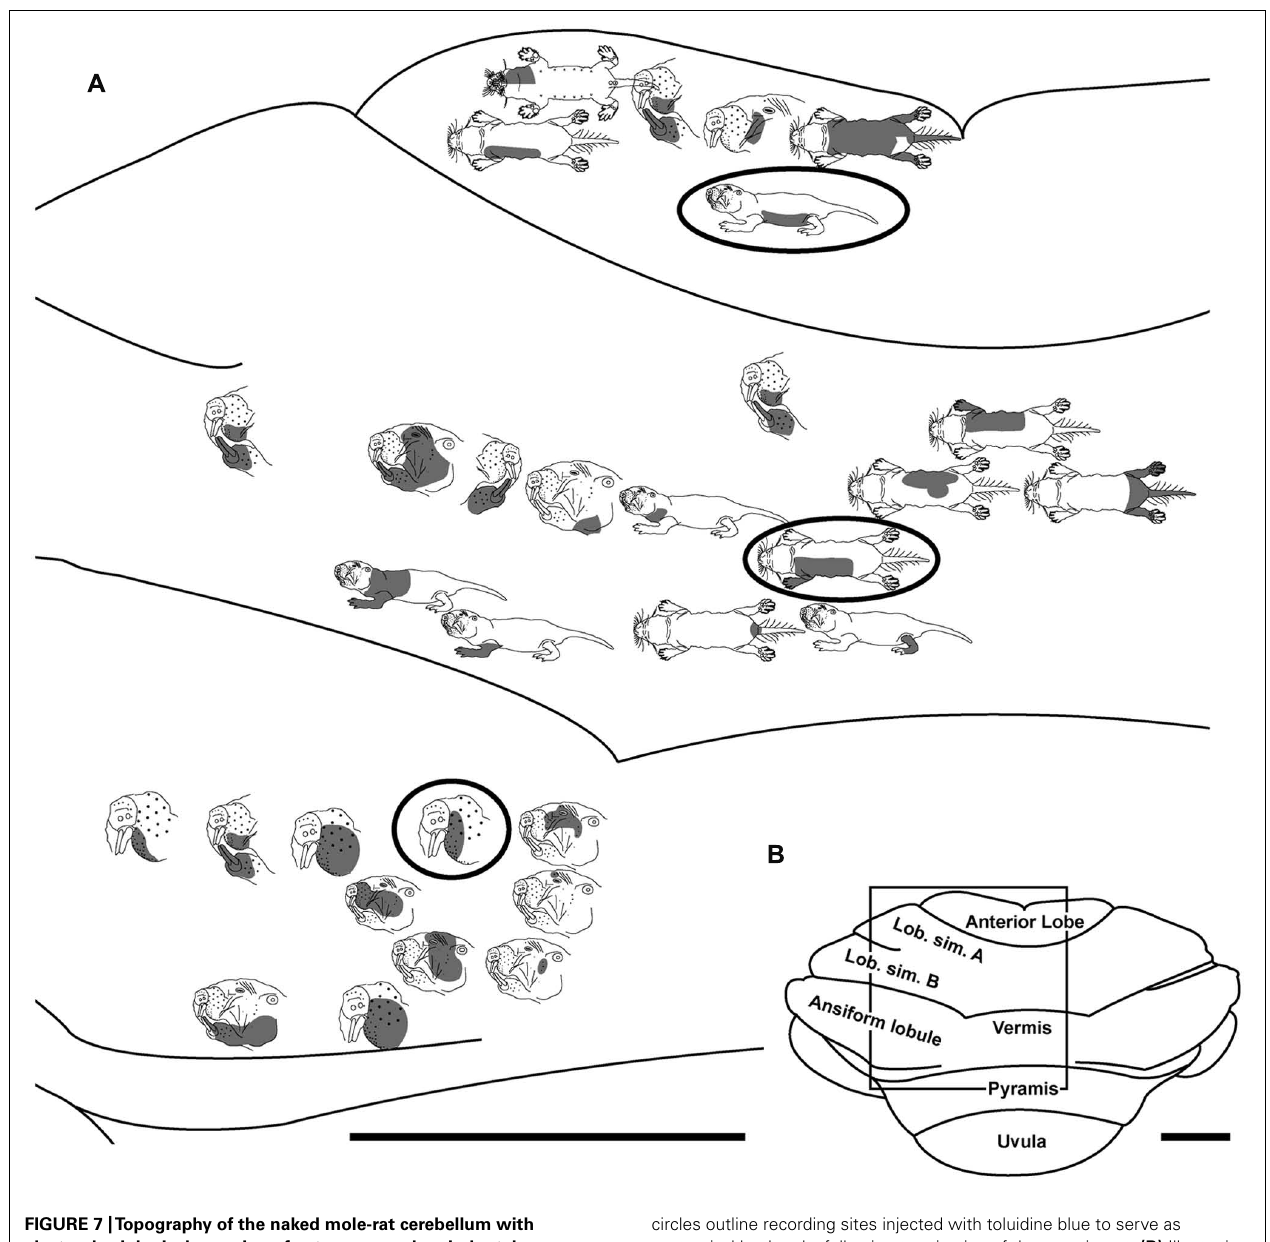
circles outline recording sites injected with toluidine blue to serve as anatomical landmarks following termination of the experiment. (B) Illustration of the naked mole-rat cerebellum with a box delineating the area exposed by craniotomy. Dorsal view, rostral is up. Animal #110708. Scale bars: 1 mm for both (A,B)